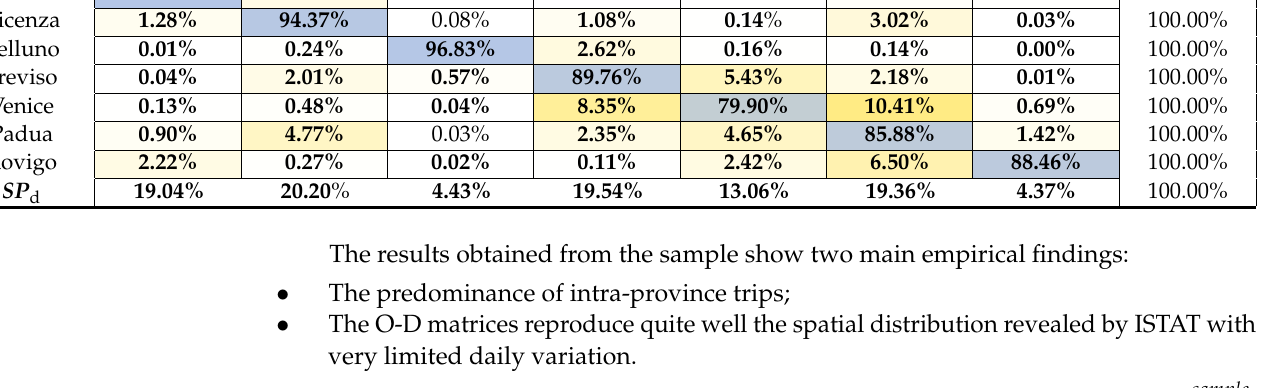
Table 4. Average yearly share of O-D flows by car from census data (source: ISTAT [71]). SW